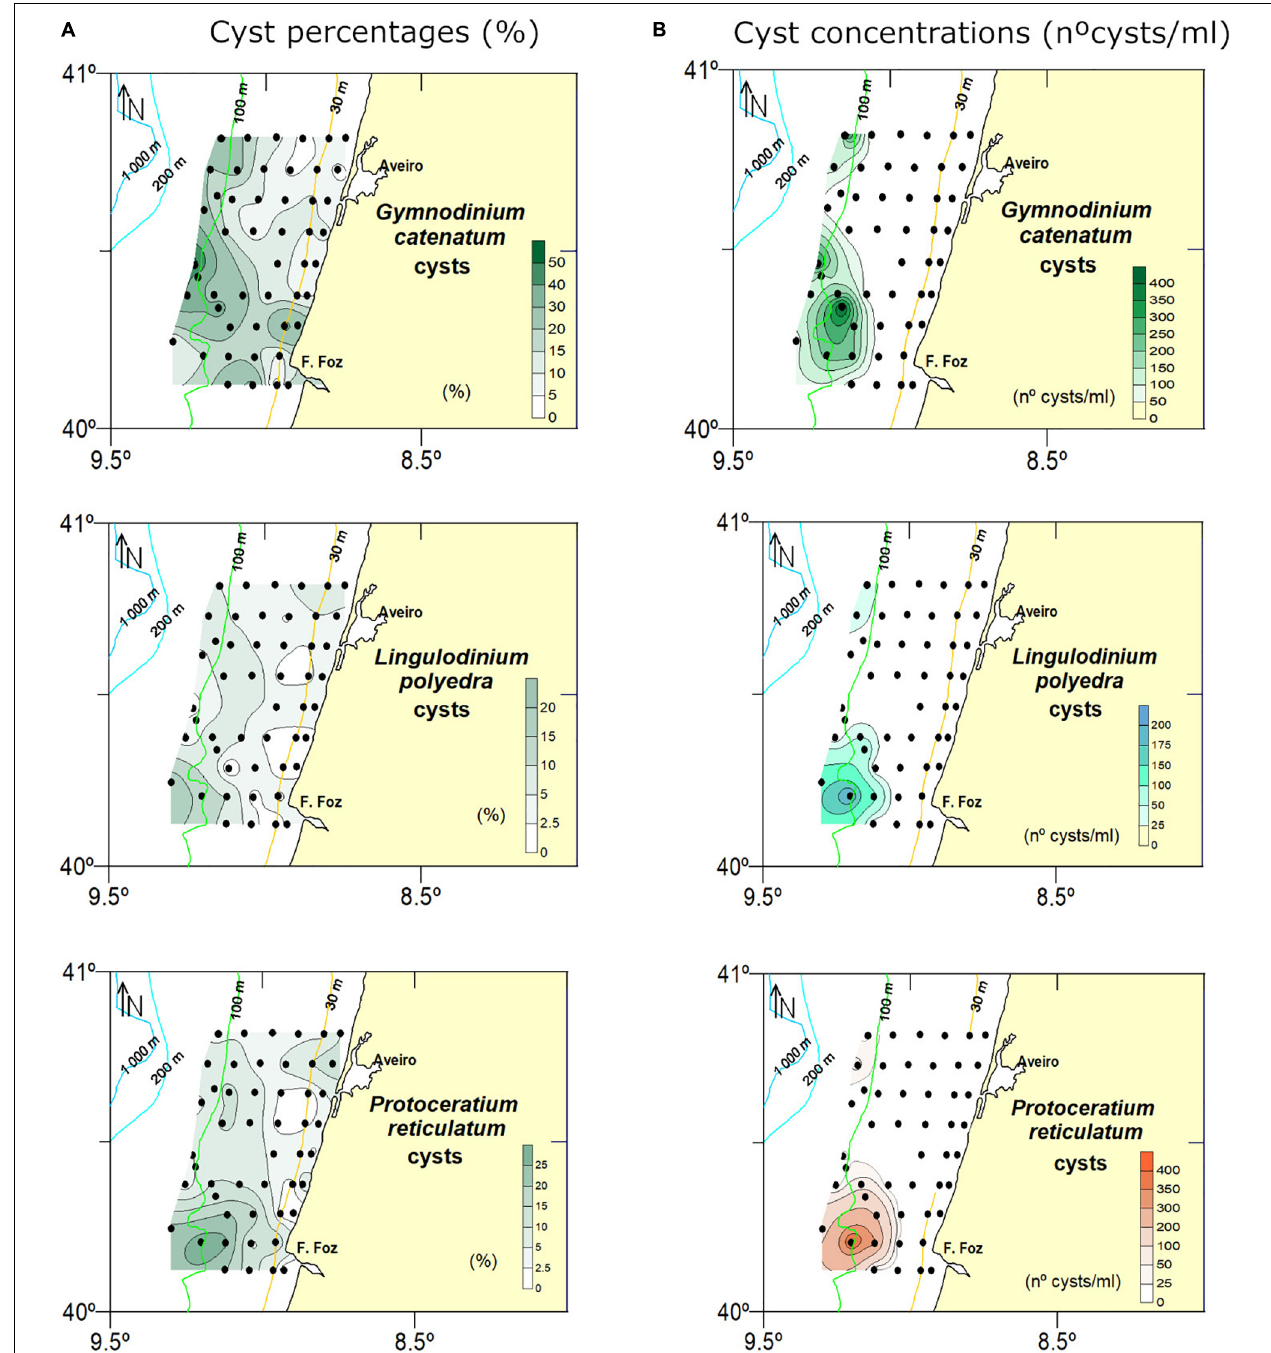
FIGURE 7 | Spatial trends in relative abundances (A) and concentrations (B) of cysts of the three HAB species ( Gymnodinium catenatum, Lingulodinium polyedra, and Protoceratium reticulatum